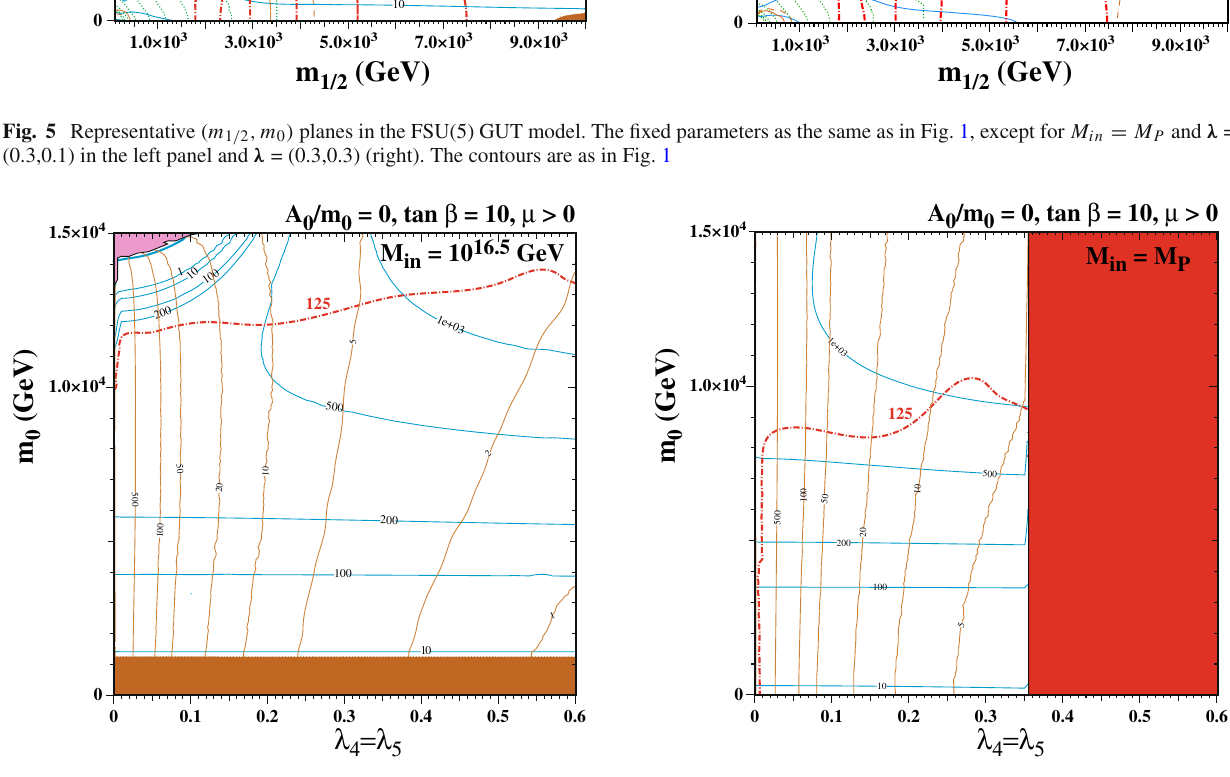
and there is no electroweak symmetry breaking in the pink shaded region, while the RGE equations break down in the red shaded band at large λ 4 = λ 5 in the right panel. The contours are as in Fig.